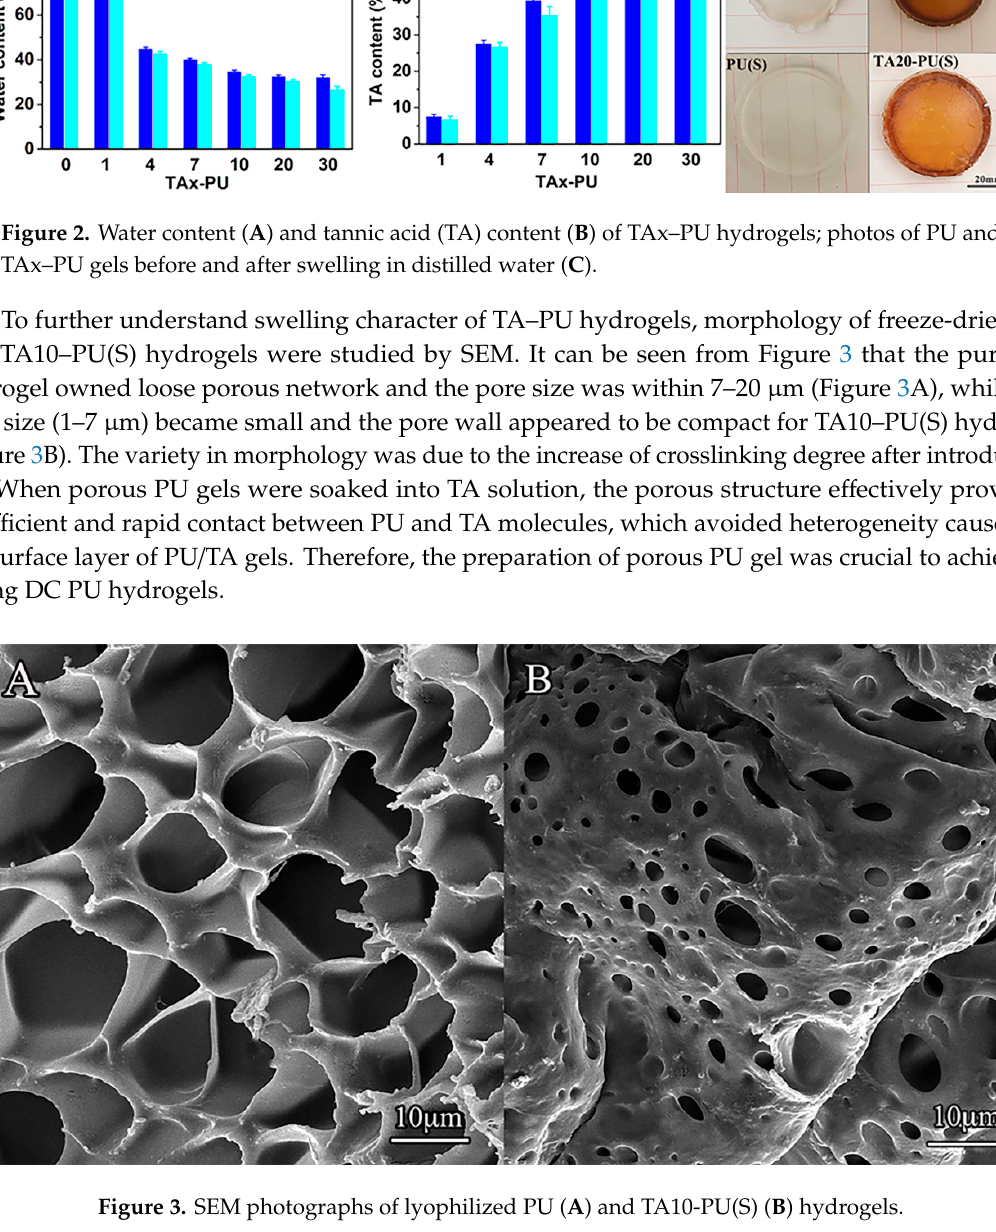
Figure 3. SEM photographs of lyophilized PU ( A ) and TA10-PU(S) ( B ) hydrogels.